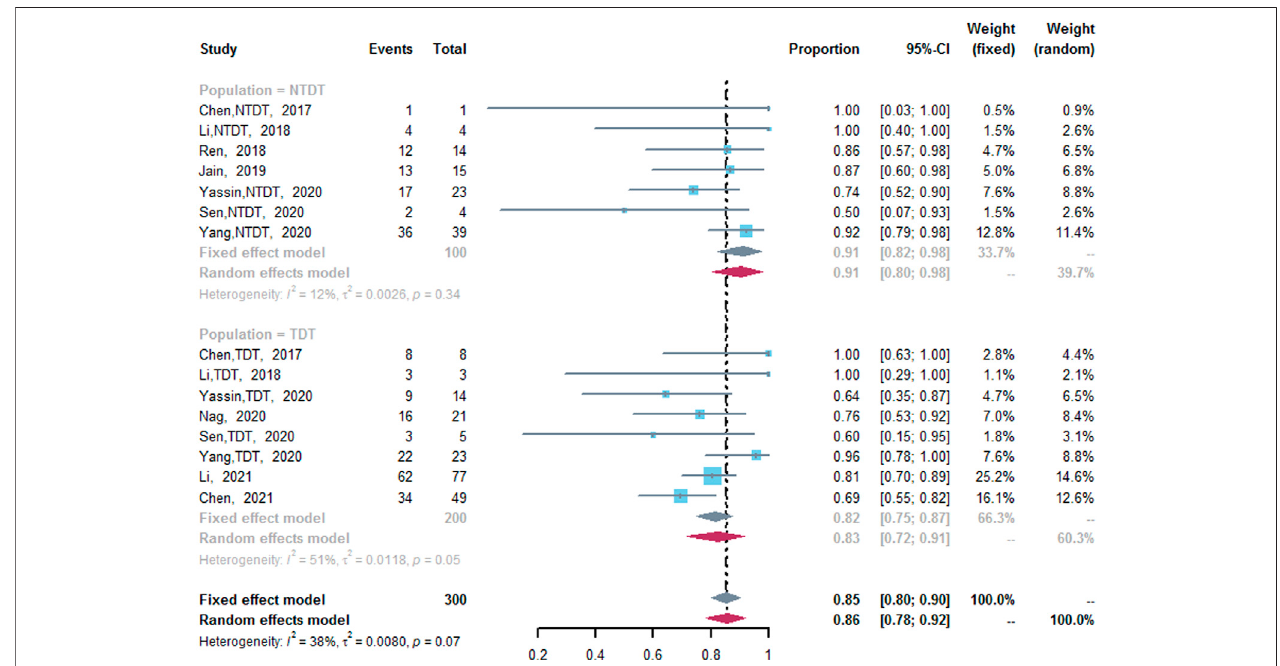
FIGURE 2 | A forest plot illustrating overall response rate in population-based subgroups.